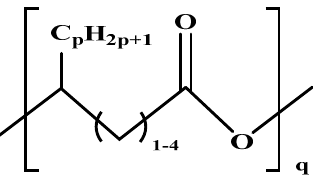
Figure 6. A common chemical structure of polyhydroxyalkanoate monomer, where p = 1 to 3; yet p = 1 is the most common monomer, 3-hydroxybutyrate; q can range from 100 to several thousand [61]. Reprinted (adapted) with permission from [61], copyright (2016) American Chemical Society.